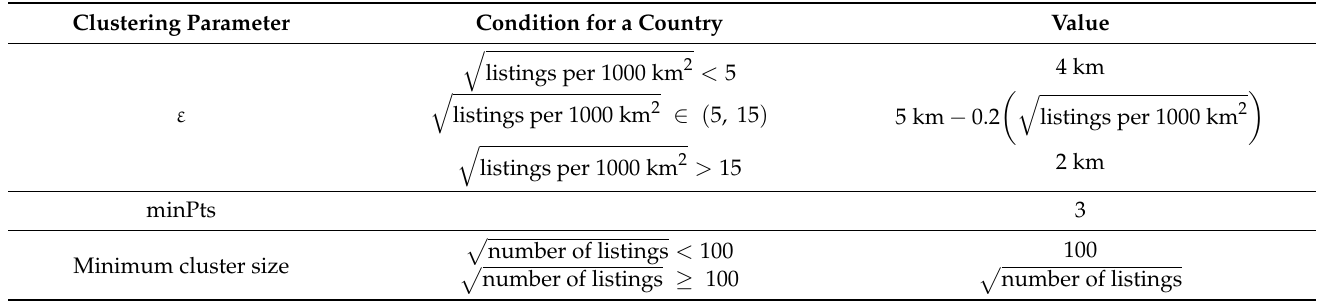
Table 1. Parameters of the DBSCAN procedure for detecting concentrated destinations.